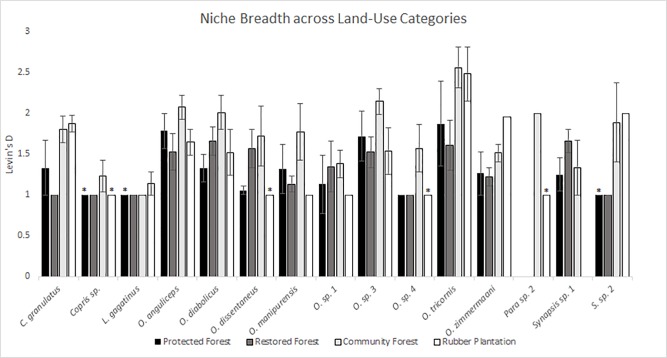
Comparison of Levin’s niche breadth for species across land-use categories.Averaged Levin’s niche breadth values for each species at each site type with standard errors. Species found on only one bait type (D = 1) are omitted (Paragymnopleurus sp. 1, O. balthasari, O. dapcauensus, O. sp. 2, O. sp. 5, Aphodius sp). Species without standard error bars were either only present during one sampling period (as indicated with an asterisk) or experienced no variation in niche breadth.